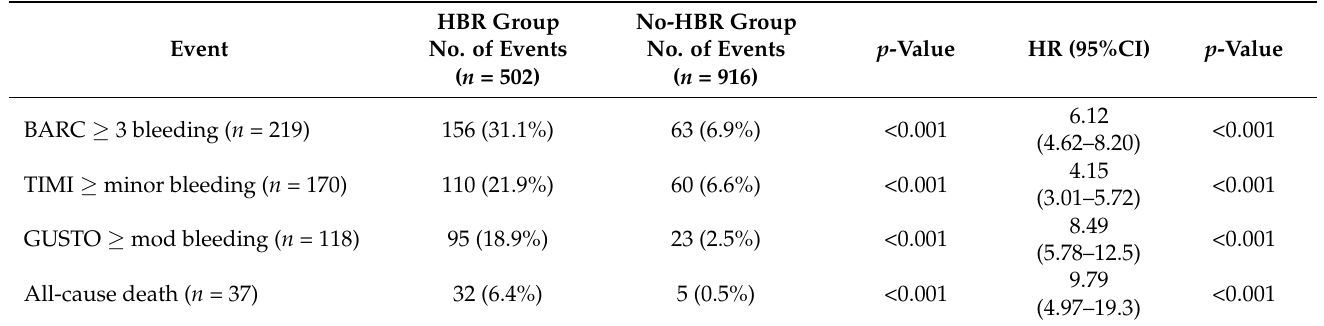
Table 2. Event rates in the HBR group.